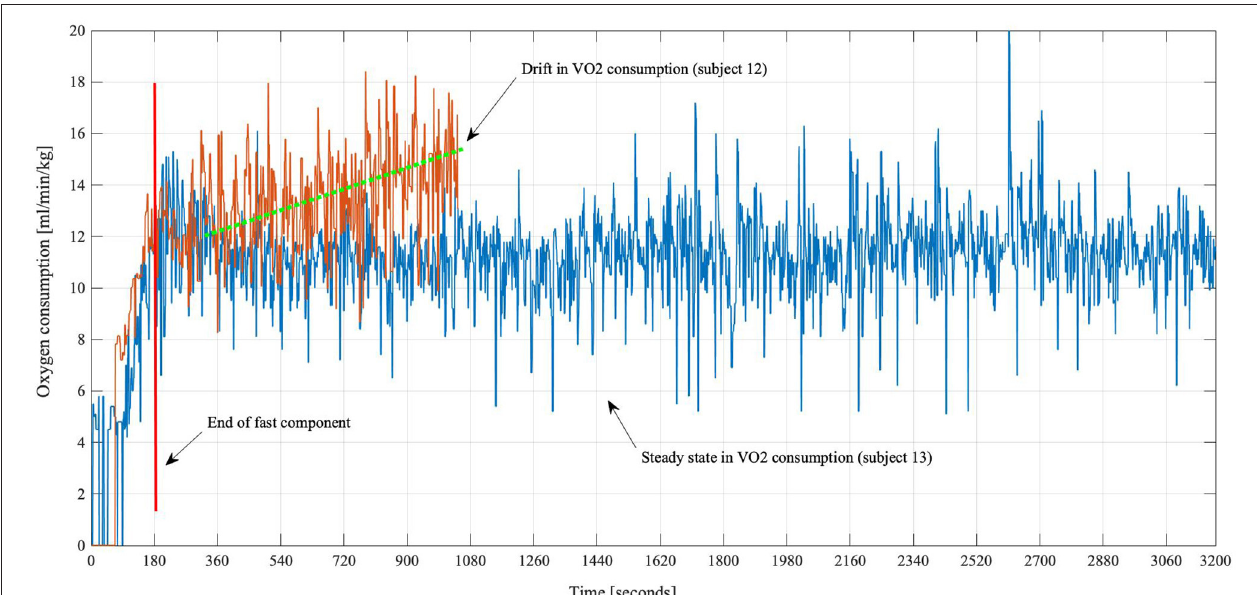
FIGURE 2 | Oxygen consumption curves of two subjects. Subject 13 (blue) showed a normal oxygen kinetic, increasing from rest and leveling off until the walking session was stopped at the maximal time of 60min. Subject 12 (orange) had to stop after approximately 17min. It is visible that the VO 2 consumption was steadily rising for subject 12.